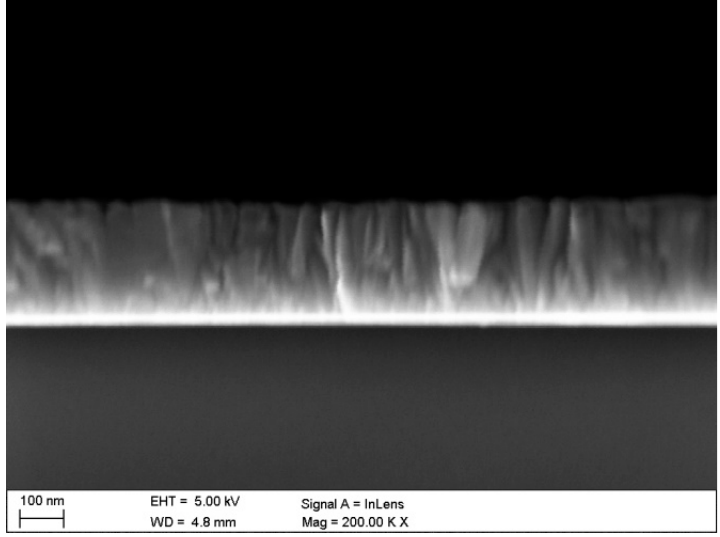
Figure 4. Thickness and roughness values of samples with a ZnO layer.